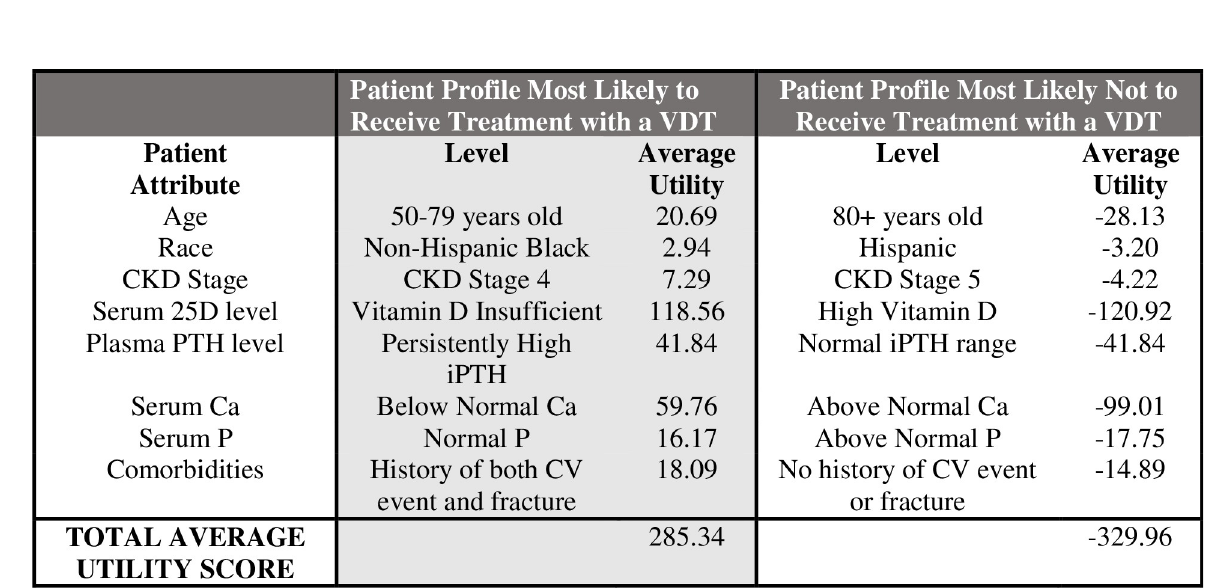
Fig 4. Patient profiles by likelihood to receive treatment with a VDT. Based on addition of average part worth utility values of selected patient attributes and their levels and comparison with the average part worth none utility value of 20.